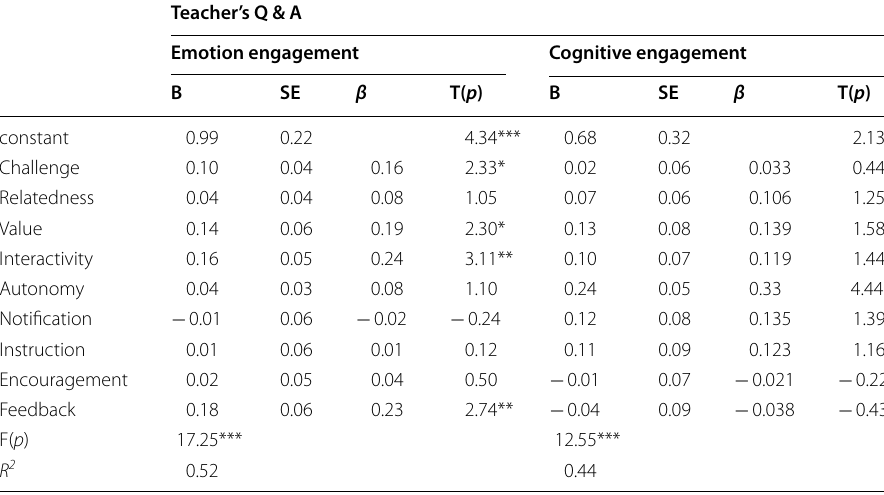
Table 5 Result 1 of Multiple linear regression analysis (n